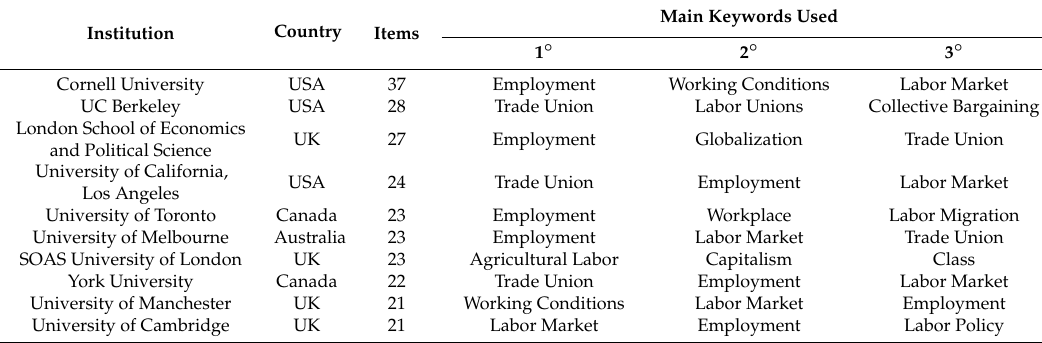
Table 1. Rankings of the 10 most productive institutions.